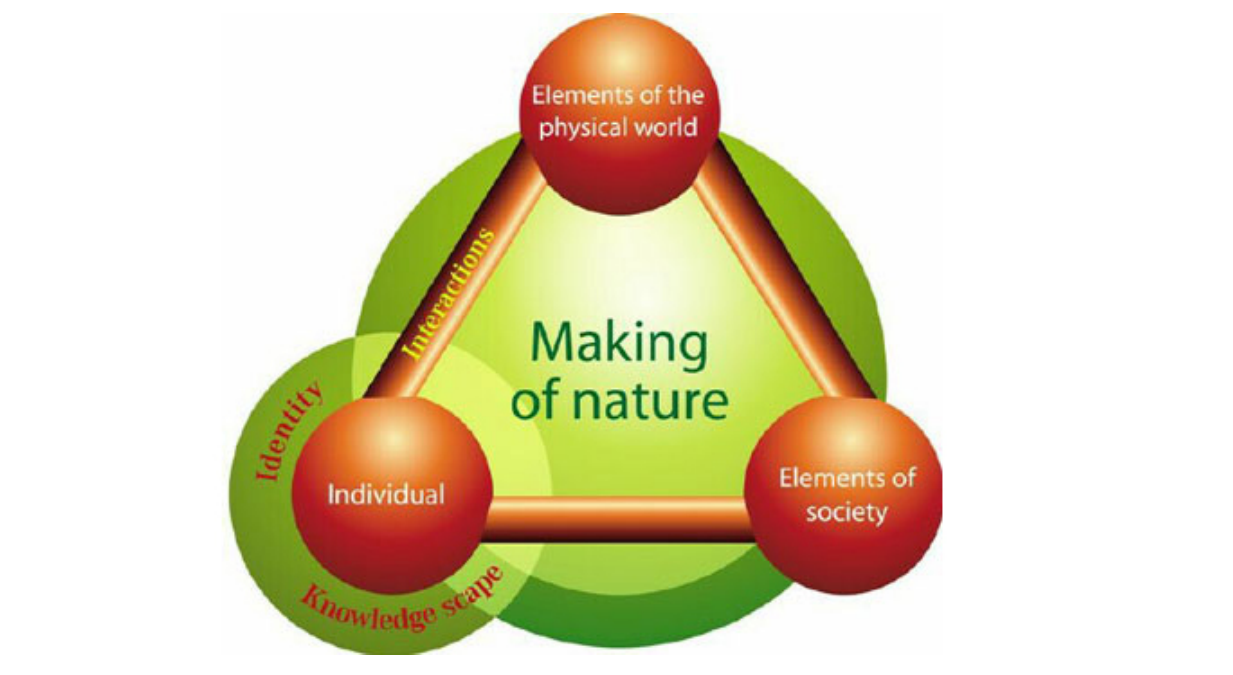
Fig. 2 . Societal relationships and the making of